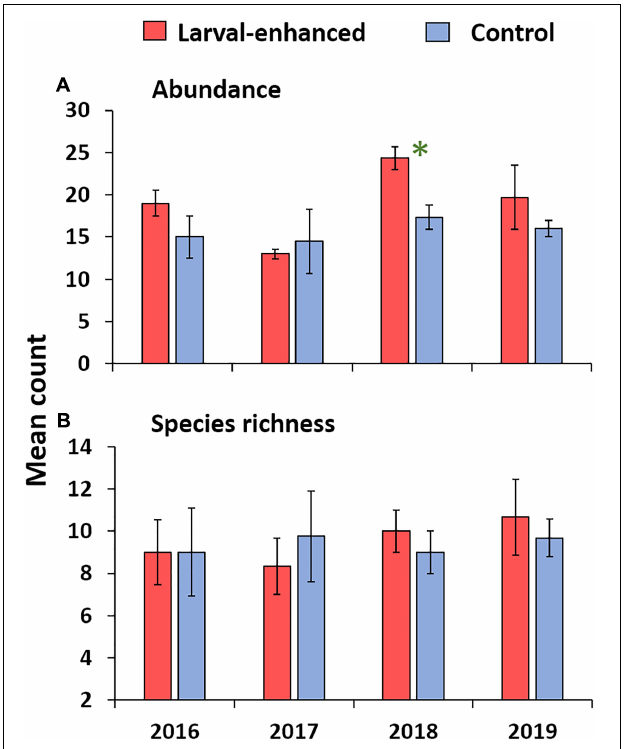
FIGURE 10 | Mean total fish abundance (A) and mean species richness (B) in larval enhanced ( N = 3) and control ( N = 3) plots before the larval restoration experiment in April 2016, and during annual surveys up to 2019. Error bars are ± SE. Asterisk denotes significant difference in mean fish abundance between larval-enhanced and control plots during 2018.